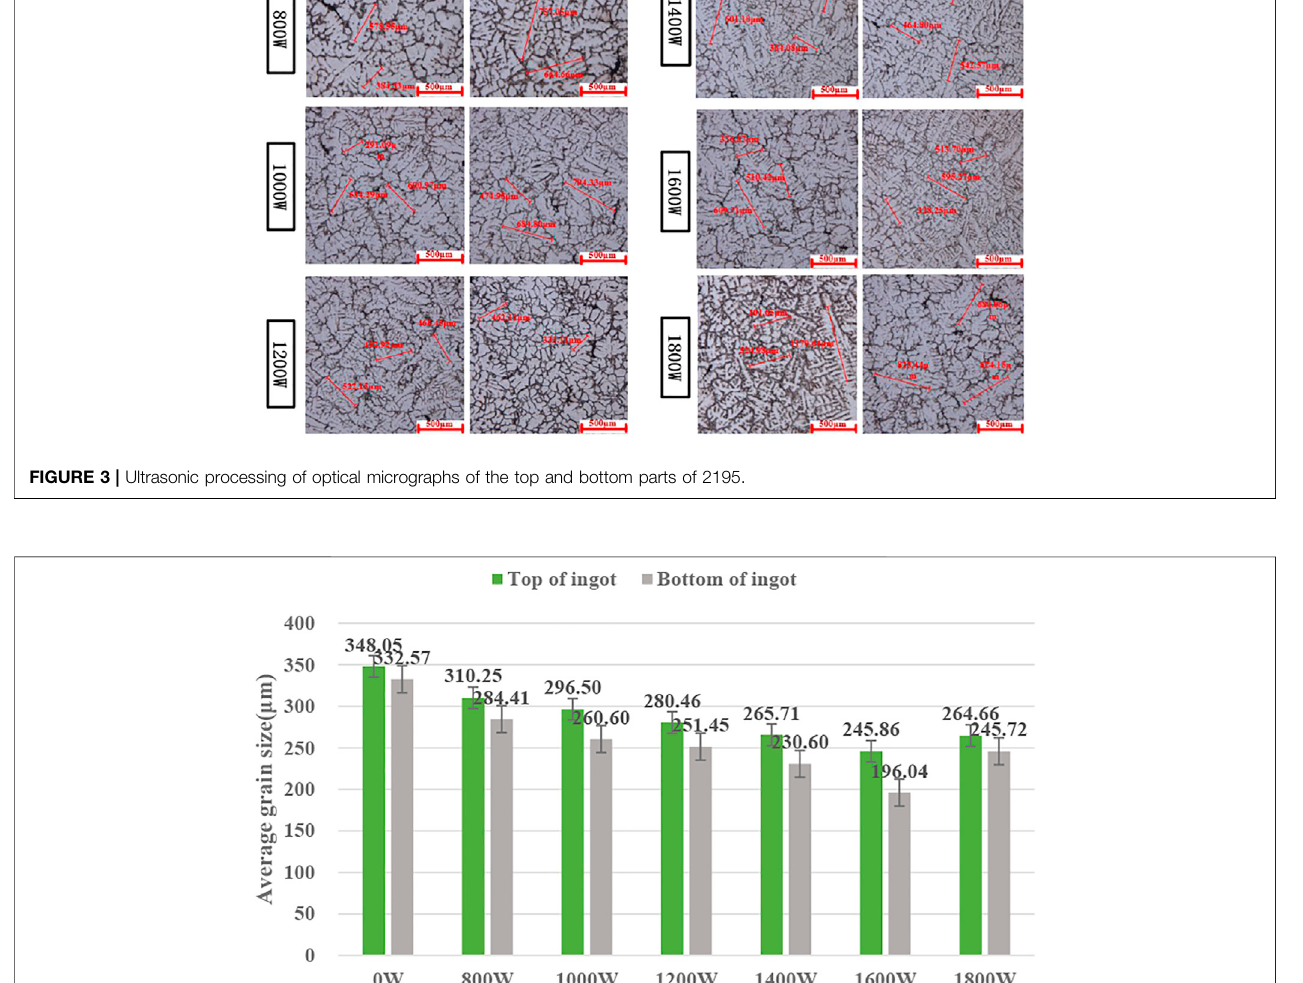
area fraction of the coarse eutectic phase and the density of the precipitated particles were counted using image quantitative analysis software (Image-Pro Plus, IPP).